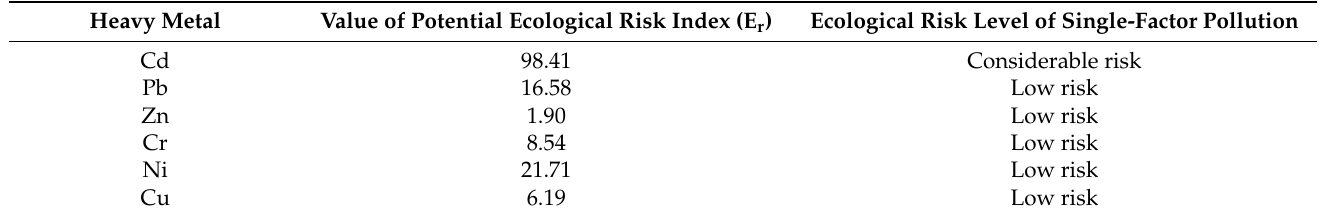
Figure 3. Spatial distribution of trace metals in the sediments of Lake Bukwałd (mg · kg − 1 of dry matter). Table 8. The value of the indicator of potential ecological risk and the degree of ecological risk of pollutants of the analyzed trace